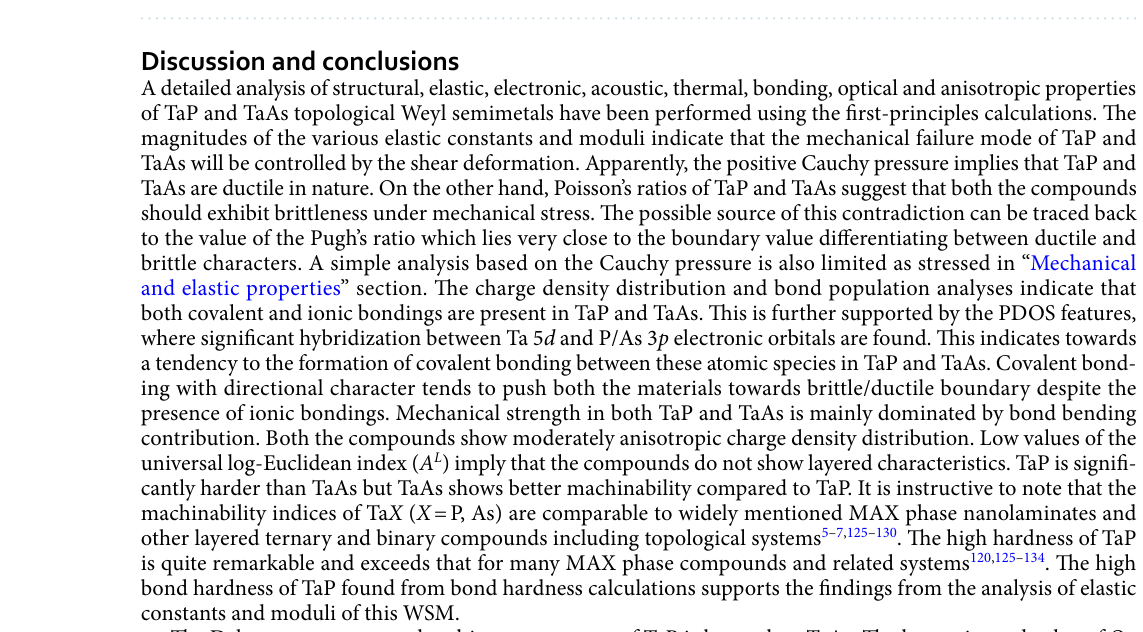
Figure 5. ( a ) Ɛ 1 ( ω ) and Ɛ 2 ( ω ), ( b ) n ( ω ) and k ( ω ), ( c ) σ ( ω ), ( d ) R ( ω ), ( e ) α( ω ) and ( f ) L ( ω ) of TaP for [99] and [001] electric field